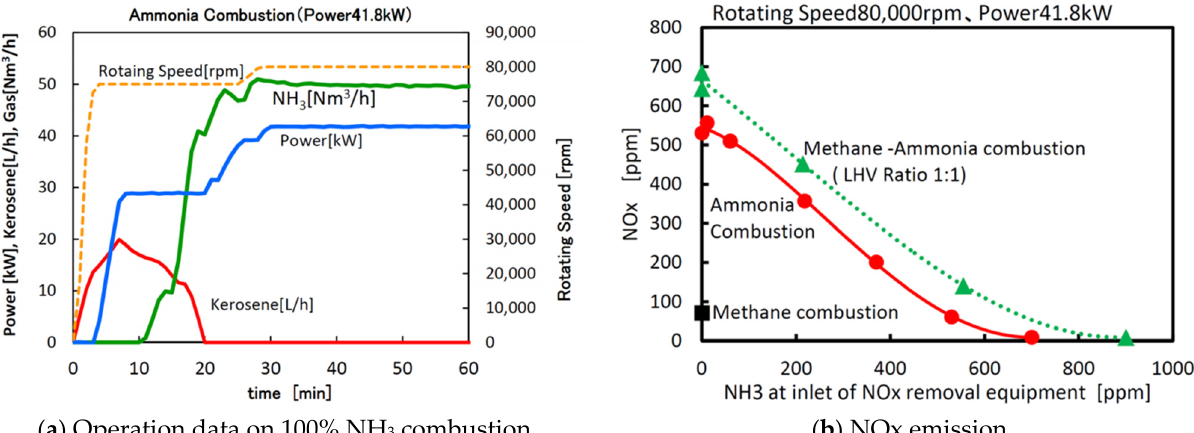
Figure 20. Operational power and NOx emissions of NH 3 combustion gas turbine: ( a ) Power output during NH 3 combustion; ( b ) NOx emissions at rotating speed 80,000 rpm and power 41.8 kW. Modified from [101]. Courtesy of Ammonia Energy Association [101].